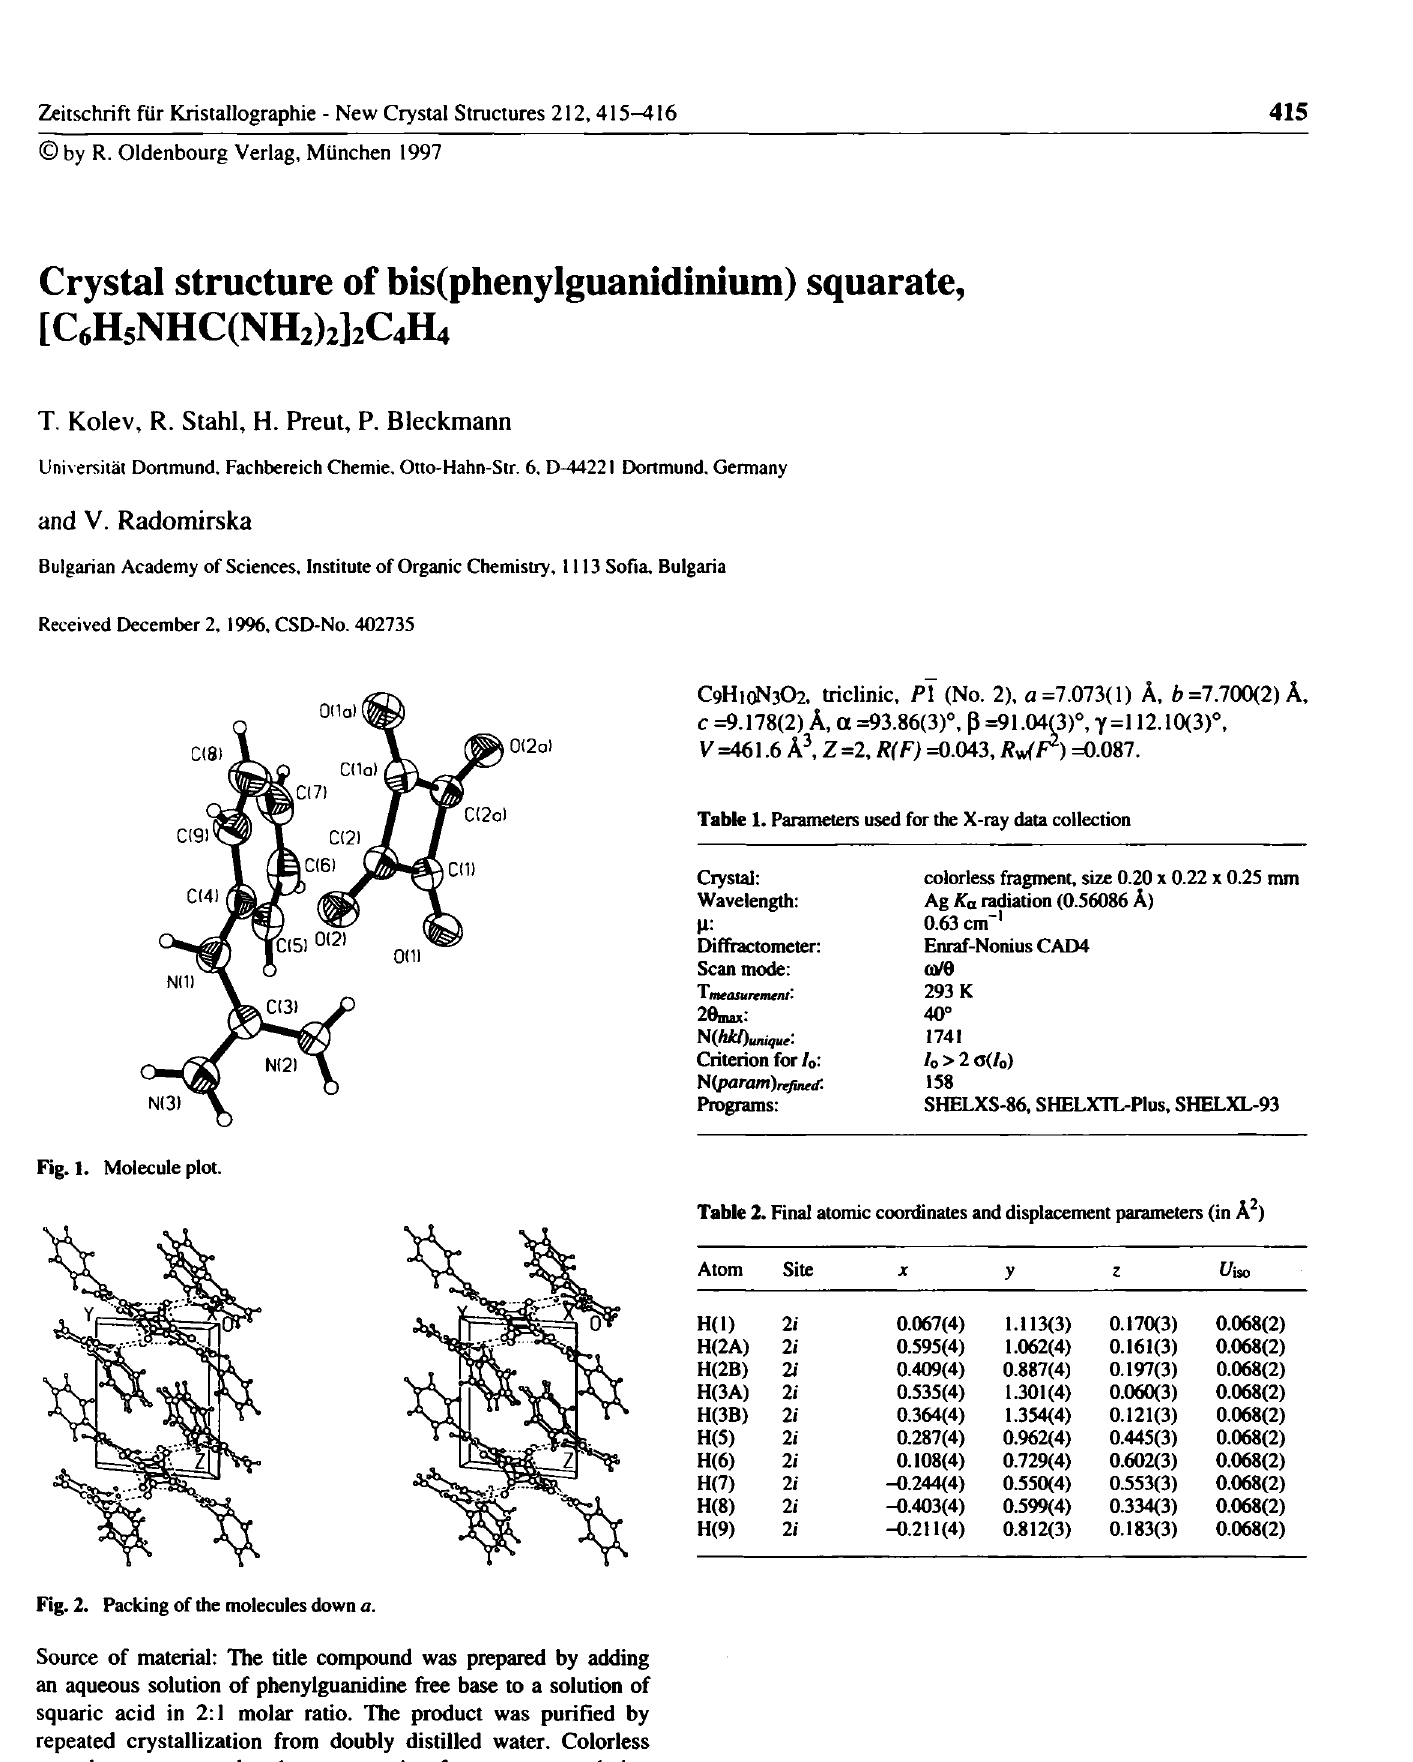
Fig. 2. Packing of the molecules down a.